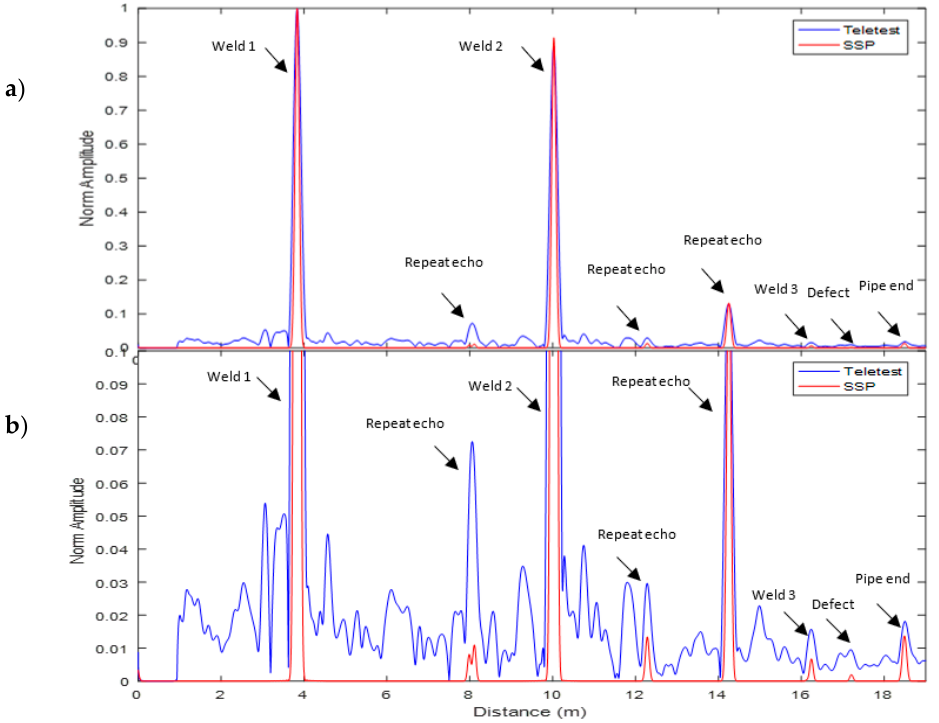
Figure 9. Unprocessed signal (blue trace) vs SSP (red trace) ( a ) the whole length of the trace ( b ) zoom-in the whole length of the trace.